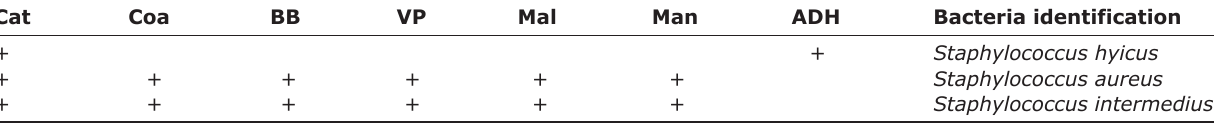
Table-2: Biochemical characteristic of Staphylococcus aureus , Staphylococcus hyicus , and Staphylococcus intermedius . Cat